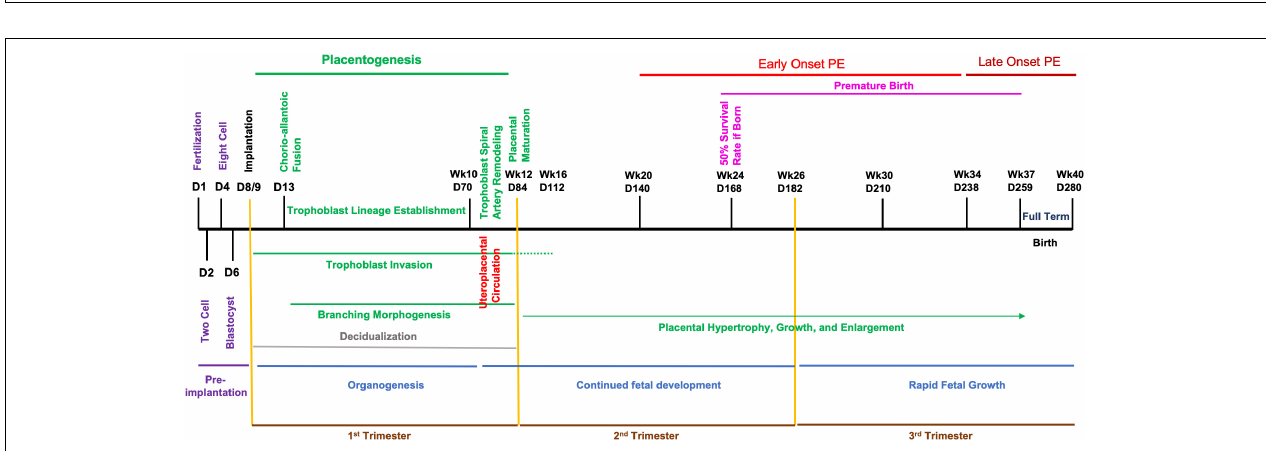
FIGURE 1 | Developmental timeline of mouse pregnancy. Graphical chronology of events associated with placental and fetal development in mice (Soncin et al., 2015; Sones and Davisson, 2016). Days of development are denoted as embryonic (E) and postnatal (P).